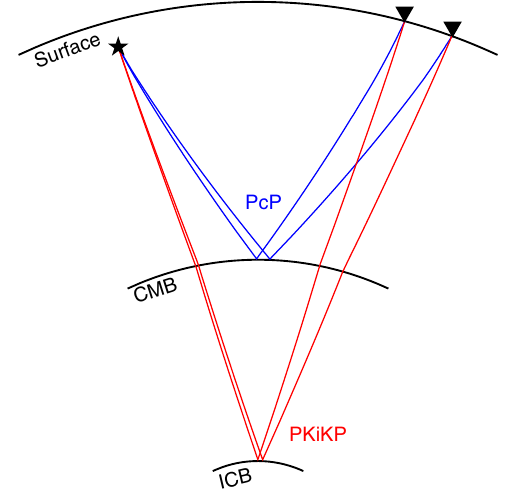
Fig. 1 Raypaths of PKiKP and PcP phases. PKiKP ( red ) and PcP ( blue ) are compressional waves re fl ected off the inner core boundary ( ICB ) and the core – mantle boundary ( CMB ) respectively. Raypaths are calculated based on PREM 29 , for a seismic source at a depth of 300 km ( black star ) and receivers ( black triangles ) at two example epicentral distances of 30°